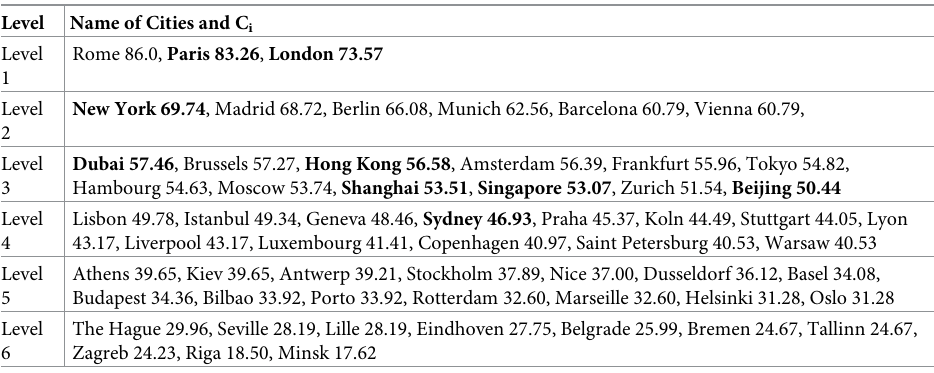
Table 3. Rough interlocking strength between Milan and other